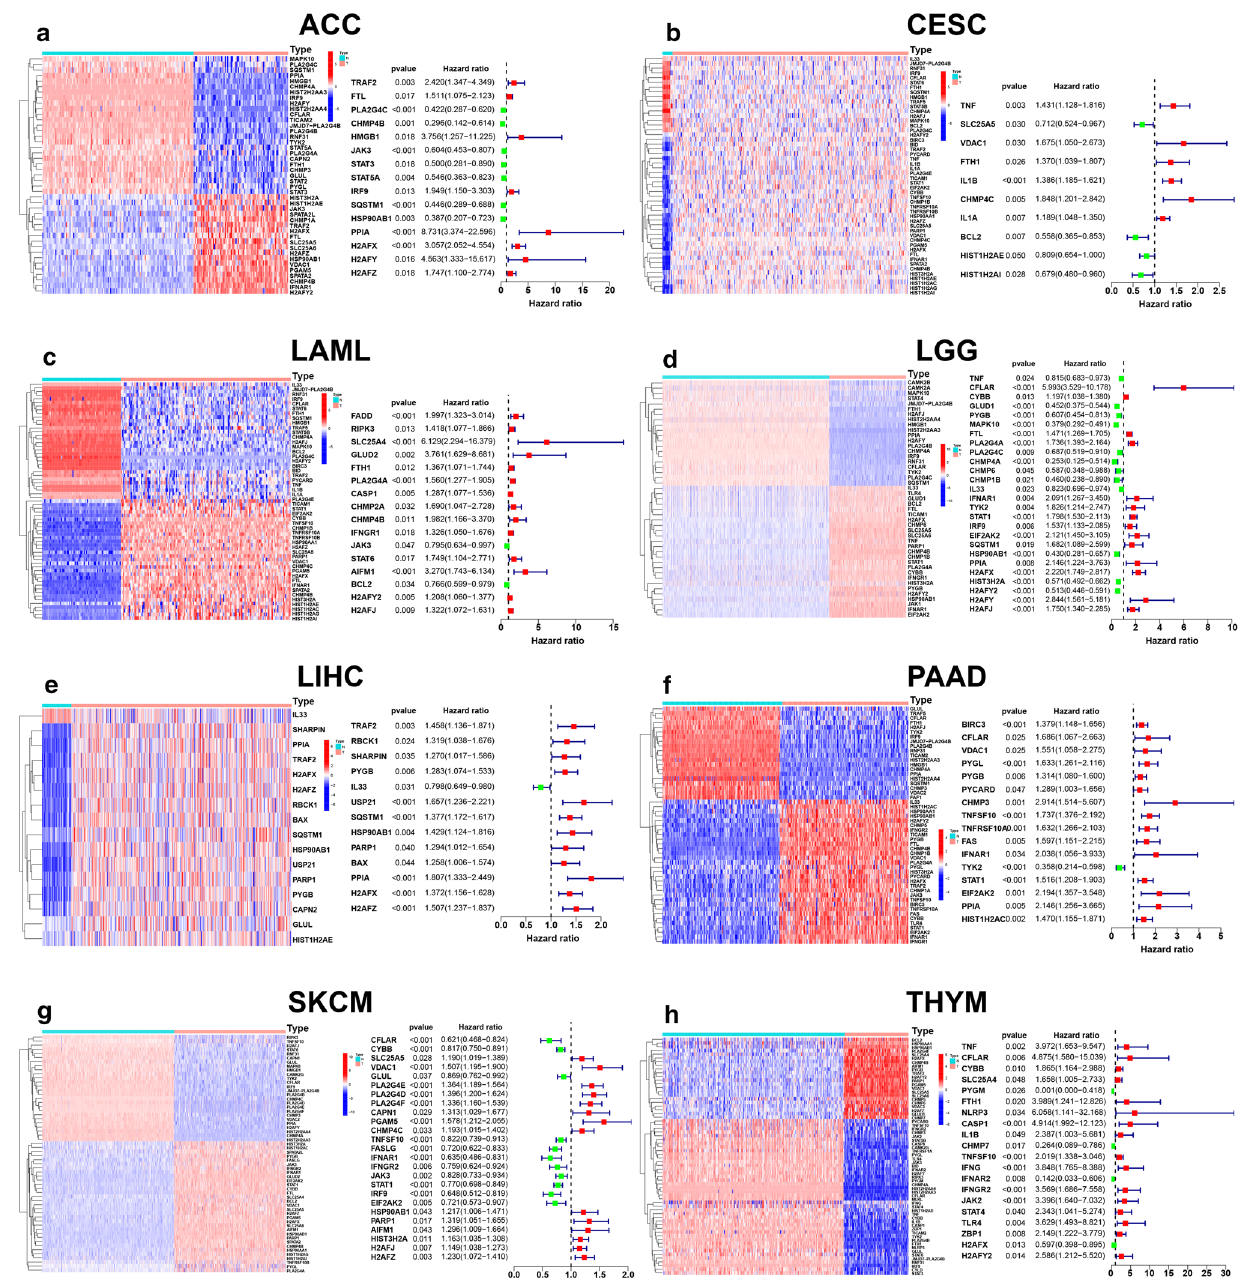
Fig. 1 Identification of differentially expressed necroptosis-related genes (DENGs) and the investigation of their prognostic effect. Top 8 can- cers with largest number of prognostic DENGs were chosen. The heat maps and forest plots showed the expression state and the prog- nostic effect of DENGs in adrenocortical carcinoma (ACC) ( a ), cervical squamous cell carcinoma endocervical adenocarcinoma (CESC) ( b ), acute myeloid leukemia (LAML) ( c ), brain lower grade glioma (LGG) ( d ), liver hepatocellular carcinoma (LIHC) ( e ), pancreatic adenocarcinoma (PAAD) ( f ), skin cutaneous melanoma (SKCM) ( g ) and thymoma (THYM) ( h ). |log2 (fold change)| > 1 and false discovery rate (FDR) < 0.05 were used as the screening criteria. Logrank p value and hazard ratio were presented beside each forest time-dependent receiver operating characteristic (ROC) curves of 1, 3, 5-years were made using “survivalROC” R package. Uni- and multi-variate survival analyses were employed to examine whether the risk score could independently affect patients’ prognosis. Model genes expression heat maps were constructed with the increase of risk score by “pheatmap” R package, and some clinical factors between patients from low- and high-risk groups were also compared by the use of Fisher’s exact test. Principal Component Analysis (PCA), t-distributed Stochastic Neighbor Embedding (t-SNE) and Uniform